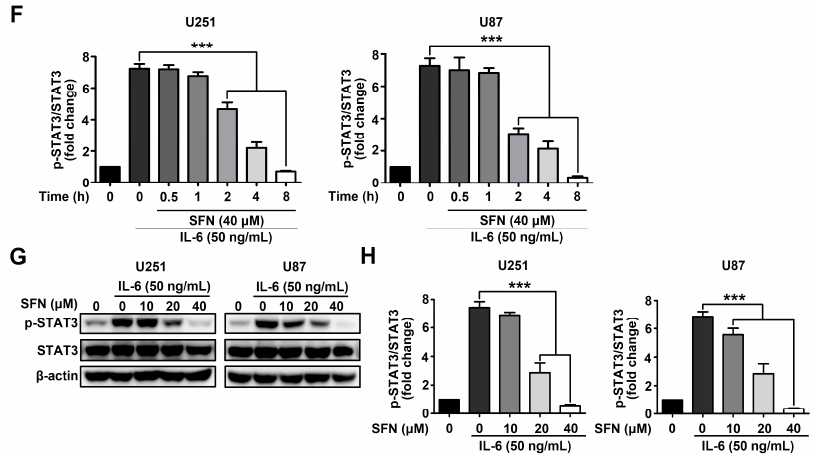
Figure 4. SFN effectively suppresses the activation of STAT3 in GBM cells. ( A , B ) Cells were treated with SFN (40 µM) and cultured for indicated time points; ( C , D ) cellswere treated with indicated concentrations of SFN and then harvested 24 h later; ( E , F ) cells were pretreated with 40 µM SFN for various time periods (0–8 h) before stimulation by IL-6 (50 ng/mL) for 15 min; and ( G , H ) cells were pretreated with SFN at indicated concentrations for 8 h before stimulation by IL-6 (50 ng/mL) for 15 min. Whole-cell lysates were processed for Western blot analysis using anti-phospho-STAT3 and anti-STAT3 antibodies. The bands corresponding to each protein were quantified and normalized relative to band intensities for control group. Data are represented as means ± SD. * p < 0.05, ** p < 0.01, and *** p < 0.001 versus the control group or the IL-6 only treatment group.